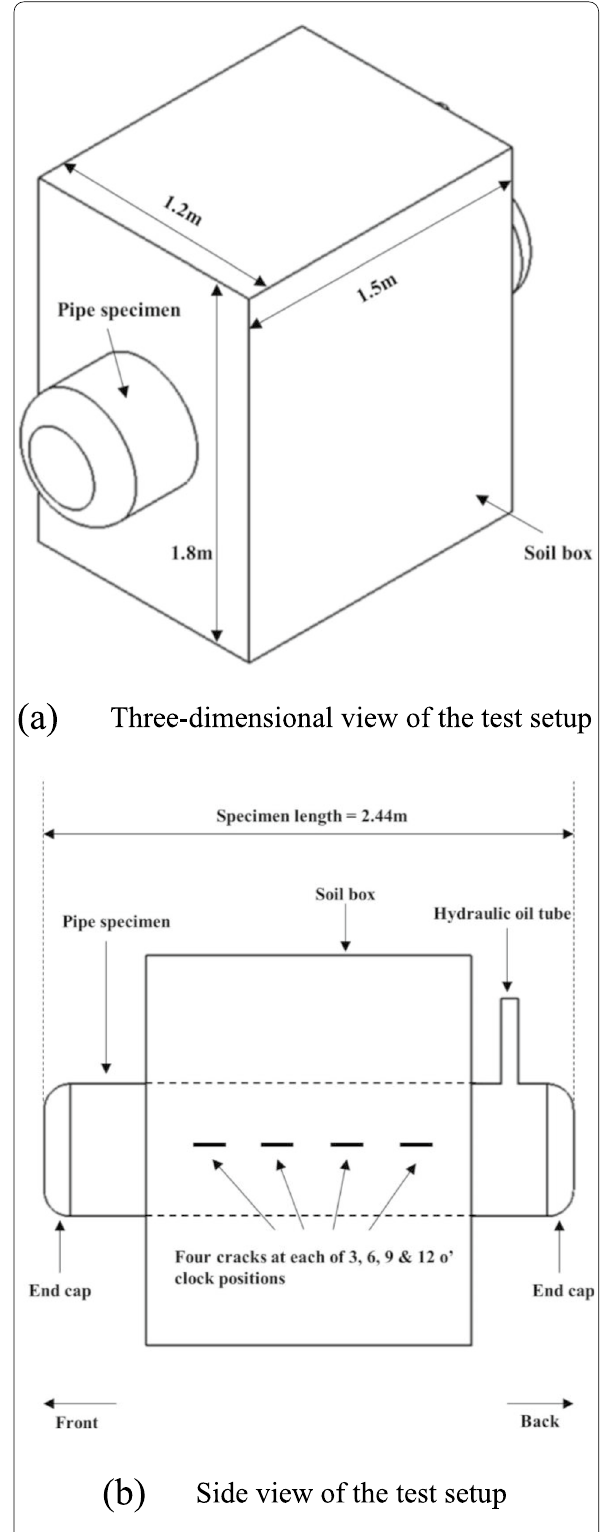
Fig. 2 Schematic illustration of the test setup for the SCC growth test. a Three-dimensional view of the test setup. b Side view of the test